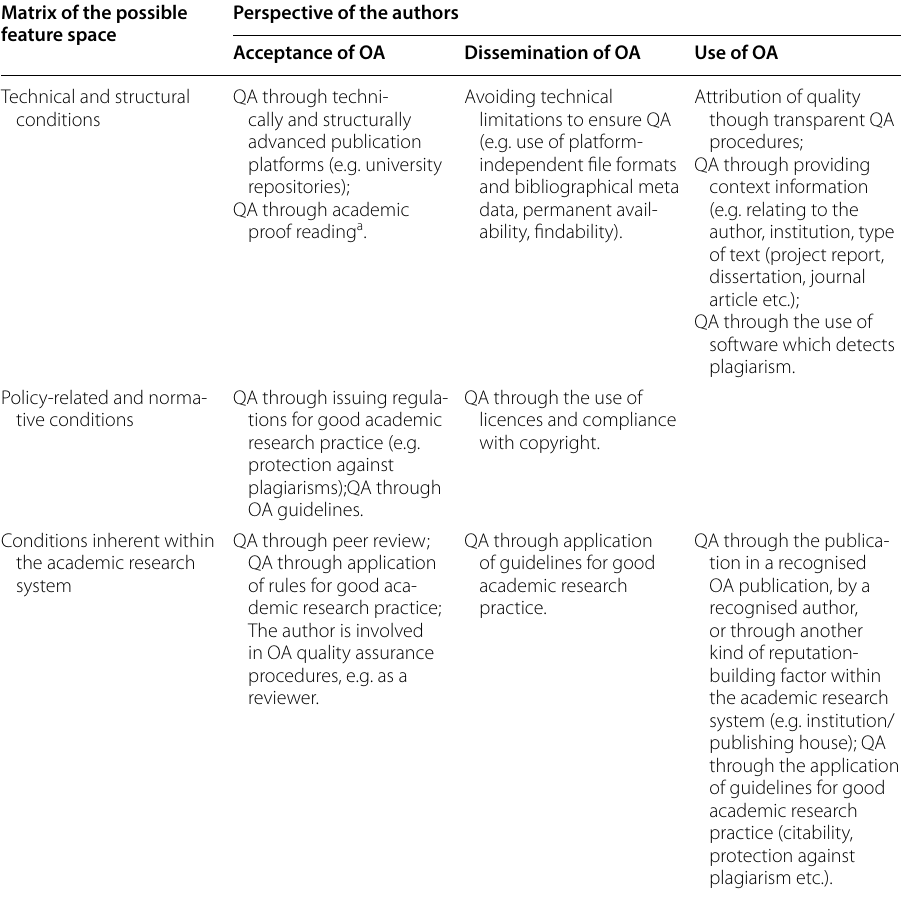
Table 5 RLTW Matrix on the aspect of quality assurance (QA) as a condition for the acceptance, dissemination and use of OA in VET